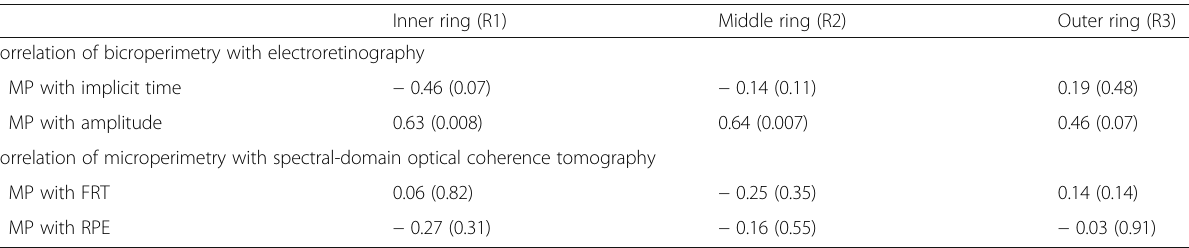
Table 2 Correlation between the mean retinal sensitivity on microperimetry with the parameters on multifocal electroretinography and retinal layer thicknesses obtained using spectral-domain optical coherence tomography among subjects with birdshot chorioretinopathy included in the study Inner ring